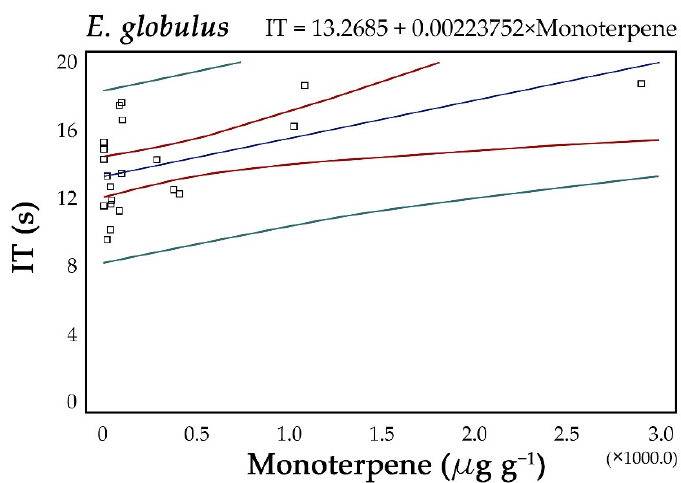
Figure 5. Results of moisture content of exotic species analyzed during summer 2020–2021. Solid bars represent mean values.